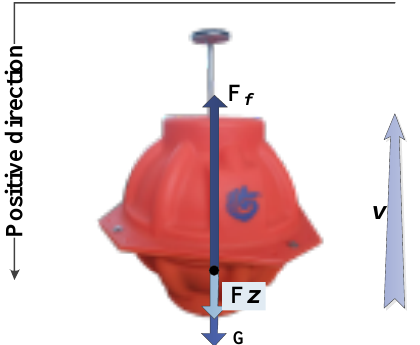
Figure 3. The force analysis of the deep-sea self-sustaining profile buoy (DSPB) in the ascent stage. F f is